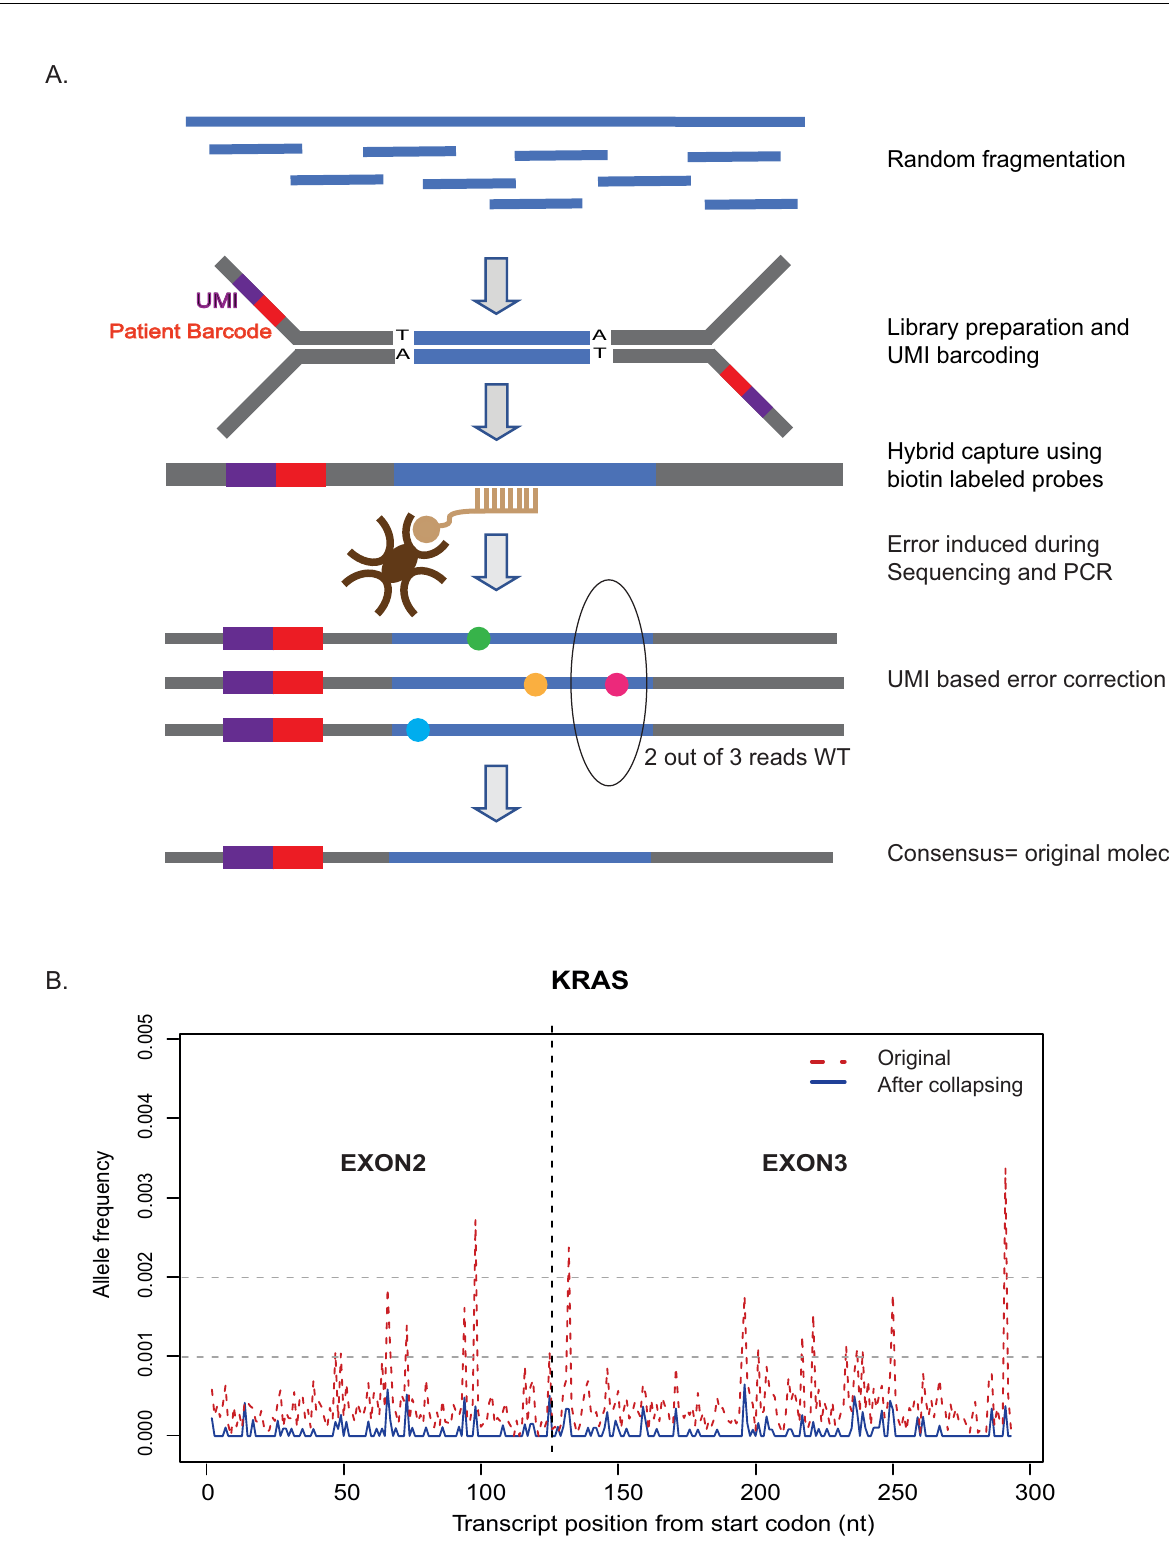
Fig 2. Error-corrected hybrid-capture NGS assay for MRD detection. (A) Each DNA molecule is tagged with a unique molecular barcode and patient barcode. DNA-seq libraries are prepared, captured for the regions of interest and sequenced. The UMIs are used for correction of errors introduced during PCR and sequencing. (B) UMI-based proofreading reduces error-associated noise. KRAS exons 2 and 3 are shown, highlighting reduction in background error rate in a representative